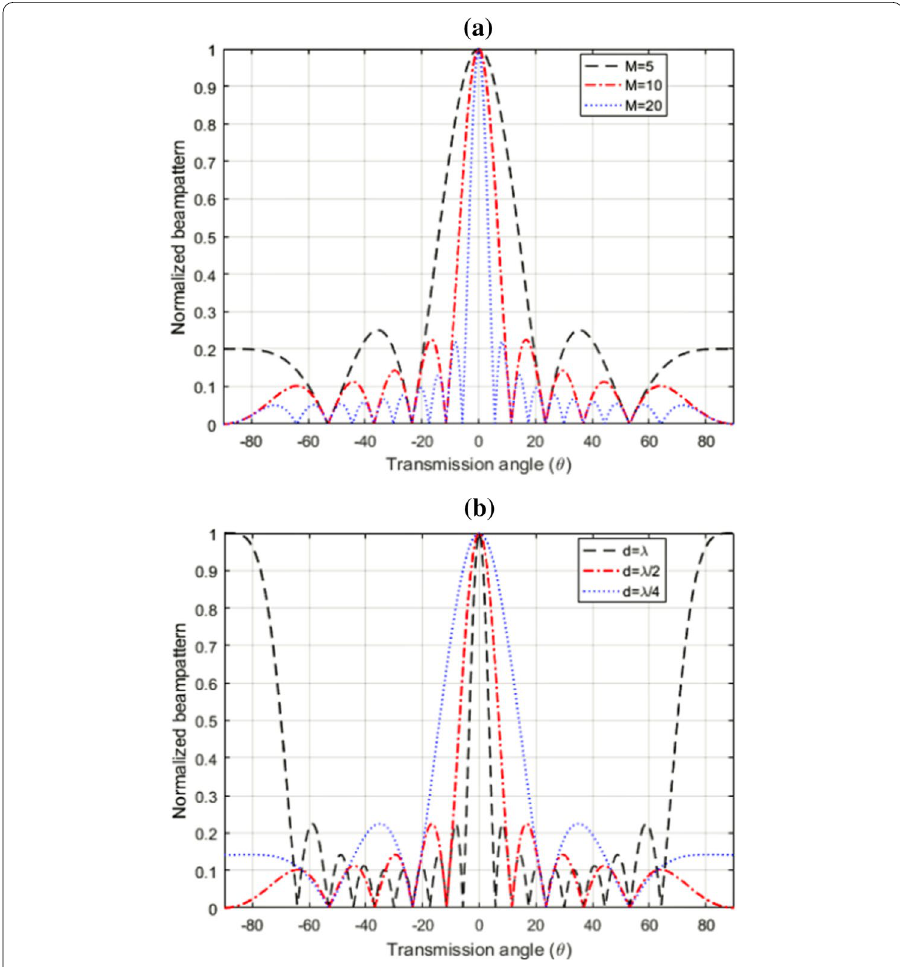
Fig. 3 Normalized phased array beampatterns with θ d = 0 ◦ . a Beampattern when M = 5 , M = 10 , and M = 15 , and d = (cid:31) 2 . b Beampattern for a 10‑elements phased array when